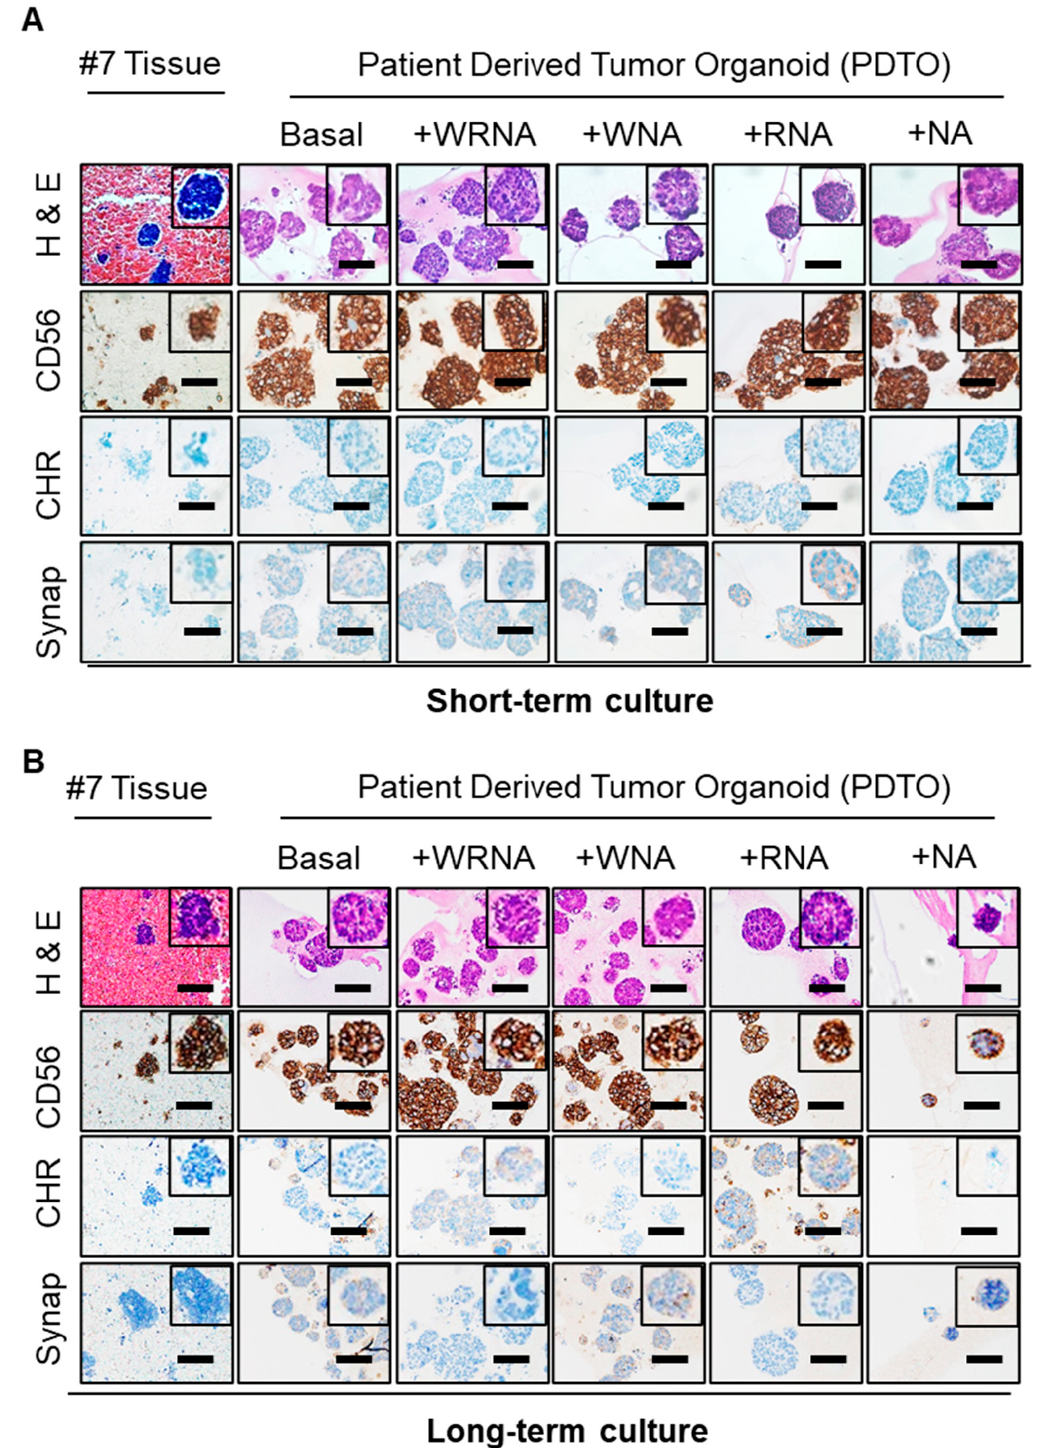
Figure 3. Essential role of the Wnt/ β -catenin pathway in long-term expansion. Hematoxylin and eosin (H&E) and immunostaining of organoids grown under culture conditions as indicated, with corresponding tumor sections. ( A ) H&E and immunostaining analysis of SPDTO #7 performed using organoids grown under 5 different culture conditions after short-term culture, together with matched tumor tissue. ( B ) H&E and immunostaining of SPDTO #7 performed using organoids grown under 5 different culture conditions for 9 months, together with matched tumor tissue. Scale bars represent 100 µm.